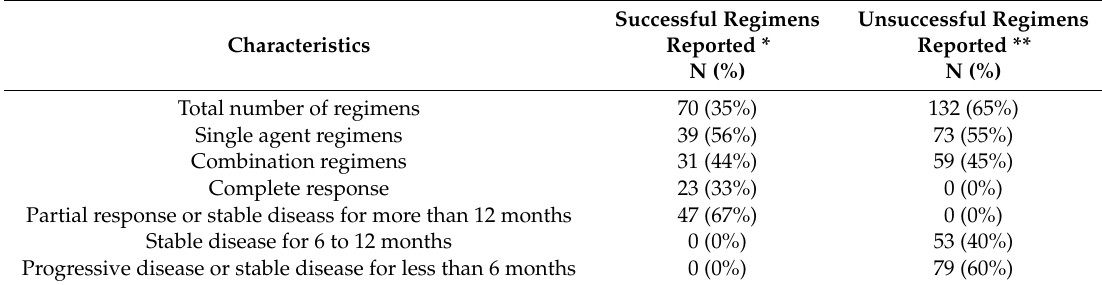
Table 1. Description of the 202 treatment regimens